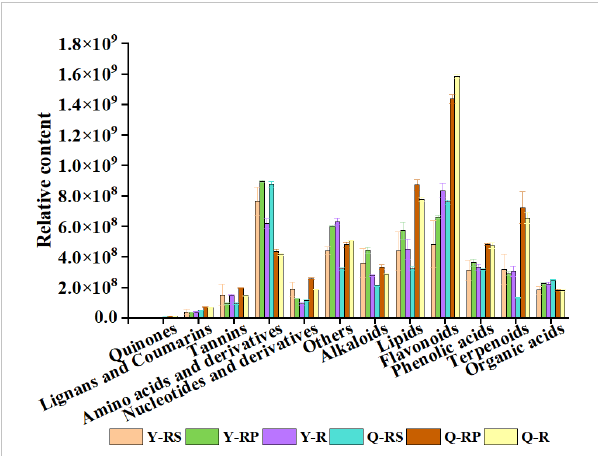
FIGURE 11 The relative content of each class of metabolites of the raspberry from different plateaus and parts. Comparison of the relative content of each category of metabolites in Y-RS, Y-RP, Y-R, Q-RS, Q-RP, and